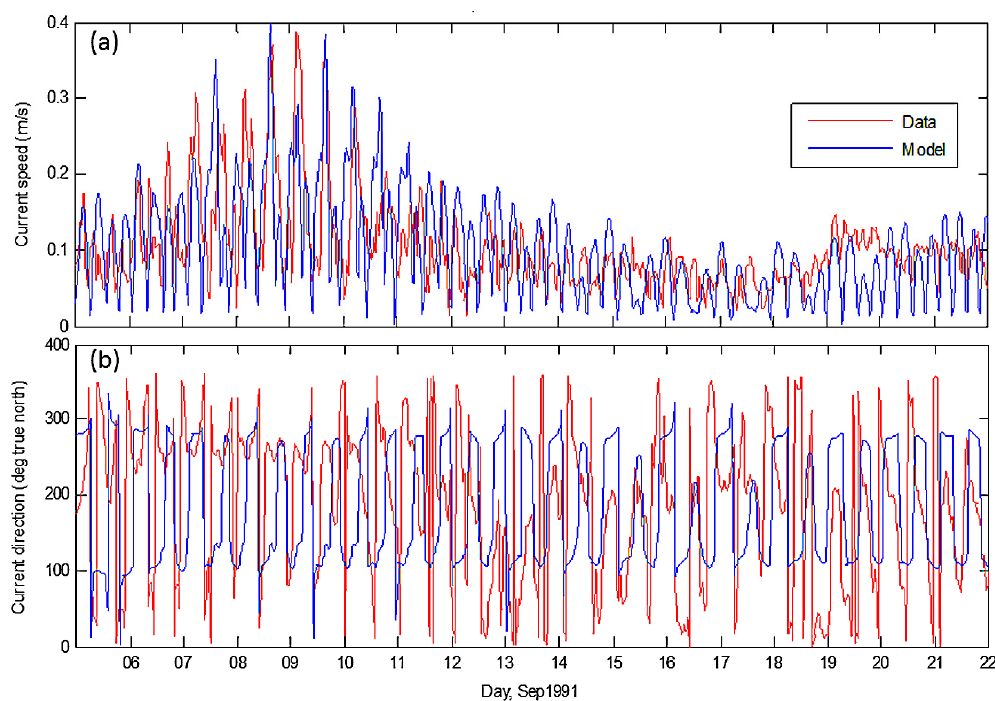
Figure 7. Modeled and measured results of current ( a ) speeds and ( b ) directions located at the historical ocean current mooring site marked in Figure 4 for ocean currents at 98 m depth. As Figure 5 in [2].